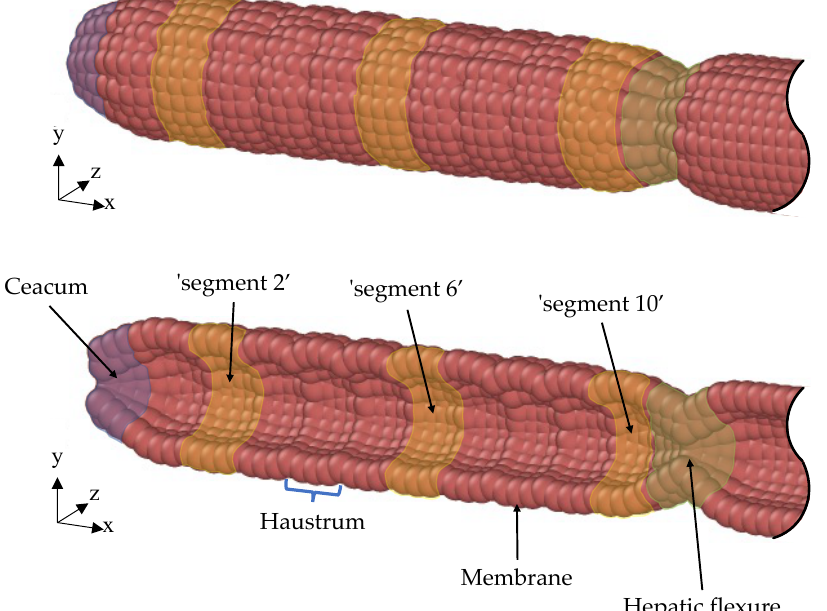
Figure 2. Schematic view ( top ) and a cross-sectional view ( bottom ) of the computational model (DCMDT). The DCMDT comprises 10 sections reflecting the DCM. Segment 1 is adjacent to the caecum and segment 10 is adjacent to the hepatic flexure . The hepatic flexure is modelled as a reduction to create a backpressure, guided by the in vivo